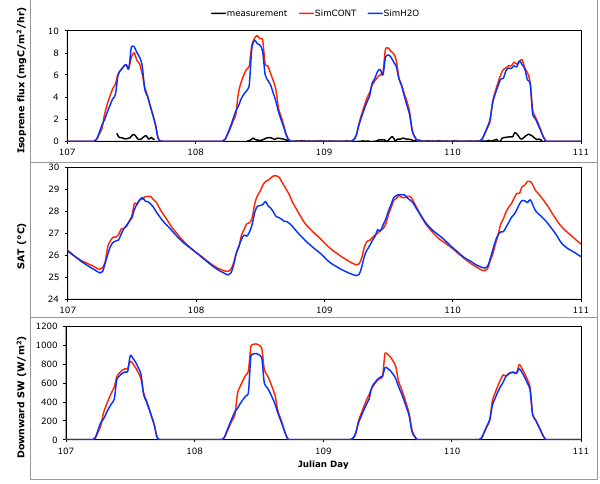
Figure 7c. Results for wet season Santarem during April 17-21 2001. Fig. 7c. (a–f) Time evolution of isoprene emission flux, surface air temperature (SAT) and downward shortwave (SW) radiation at the tropical measurement sites. Measurements are shown in black (where data is available). Model climatological results are averages of 10 simulation years in SimCONT (red) and SimH2O (blue). (c) wet season Santarem during 17–21 April